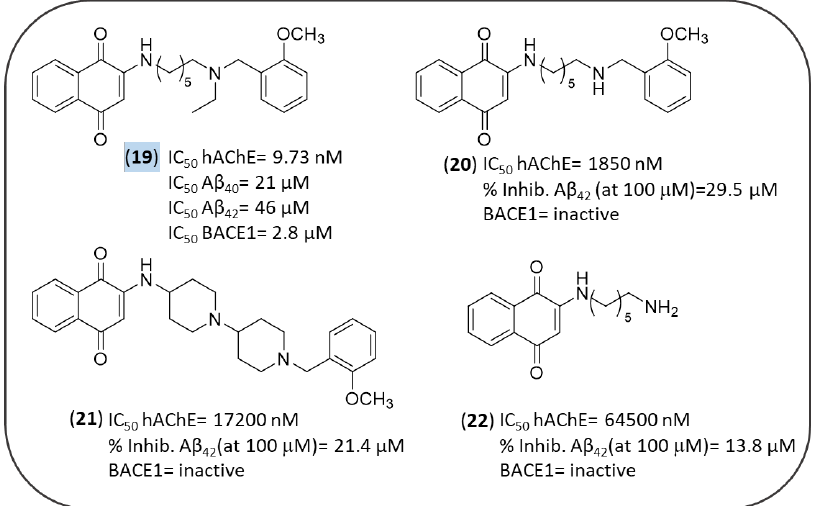
Figure 7. NQs studied by M.L. Bolognesi et al.